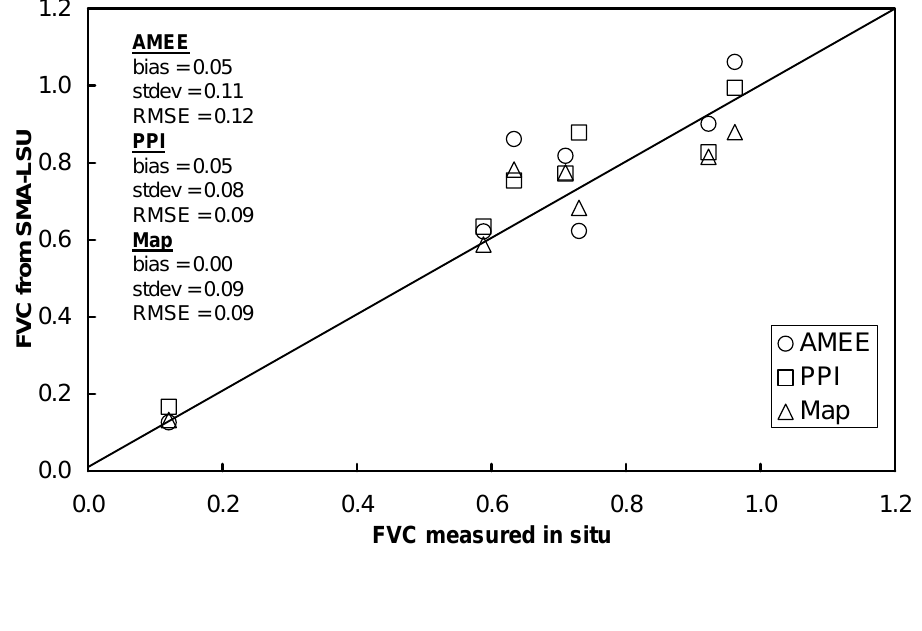
Figure 15. Comparison between the FVC retrieved from Spectral Mixture Analysis and Linear Spectral Unmixing (SMA-LSU) and the one measured in situ. In the SMA-LSU technique, endemembers have been extracted using the Automated Morphological Endmember Extraction (AMEE) method, the Pixel Purity Index (PPI) and the land use map of the study area (Map). ‘Bias’ is the mean difference between the retrieved FVC and the one measure in situ, ‘stdev’ is the standard deviation of the bias, and ‘RMSE’ is the Root Mean Square Error computed as square sum of the bias and the